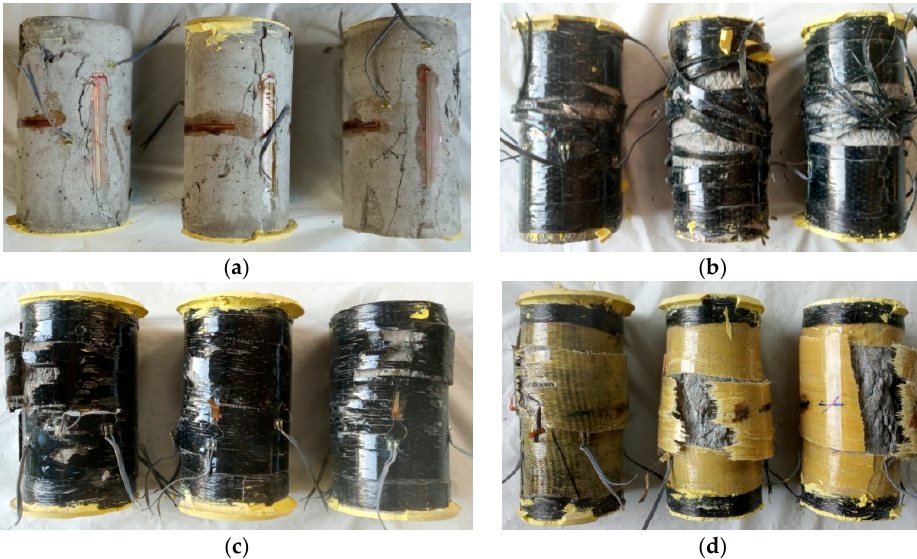
Figure 3. Typical failure modes of the unconfined concrete and FCHC specimens: ( a ) S-0; ( b ) S-C1; ( c ) S-B1; and ( d ) S-A1.